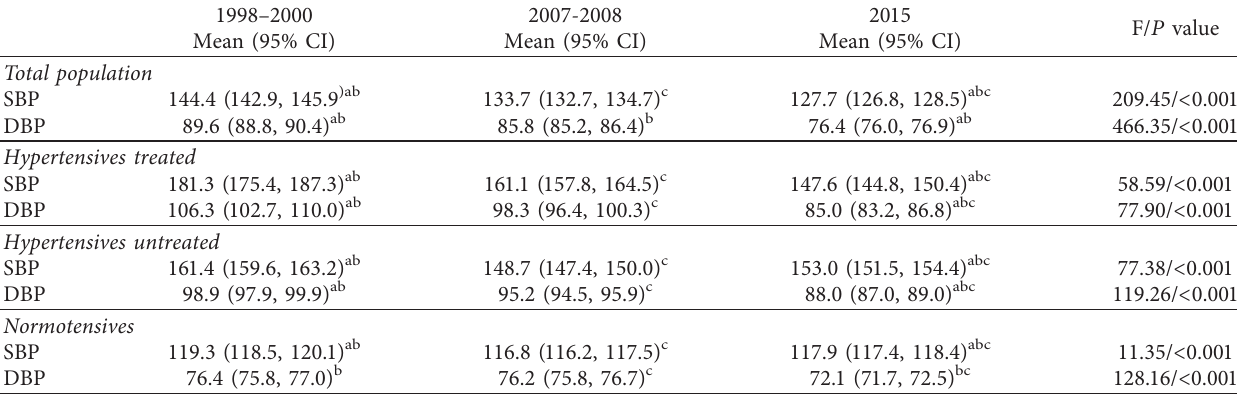
Table 3: Trends in blood pressure in study population between 1998 and 2015 (mmHg).